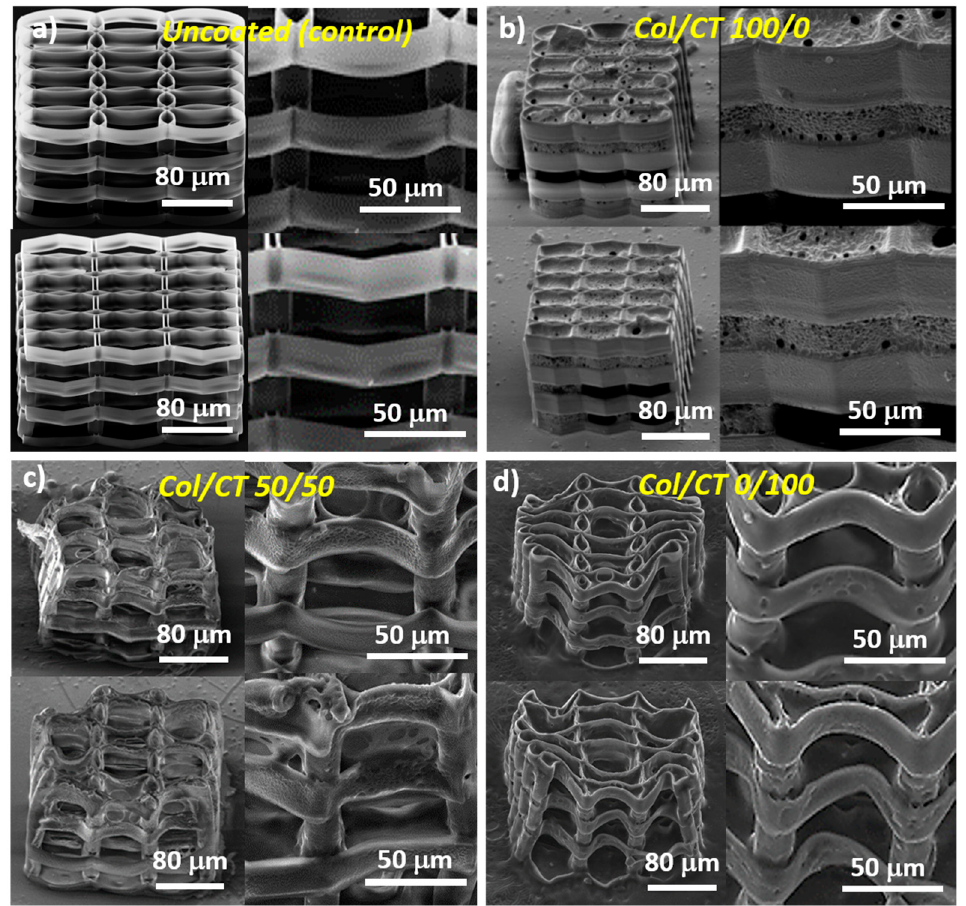
Figure 1. SEM micrographs of 3D structures produced by LDW via TPP: ( a ) uncoated structures; ( b – d ) 3D structures functionalized with Col/CT with different blending ratios. For ( a – d ): the upper panels illustrate 3D structures with ellipsoidal units; the lower panels illustrate 3D structures with hexagonal units; the left panels show overviews of the structures tilted with 30 deg; the right panels show closer views of the structures depicted in the left